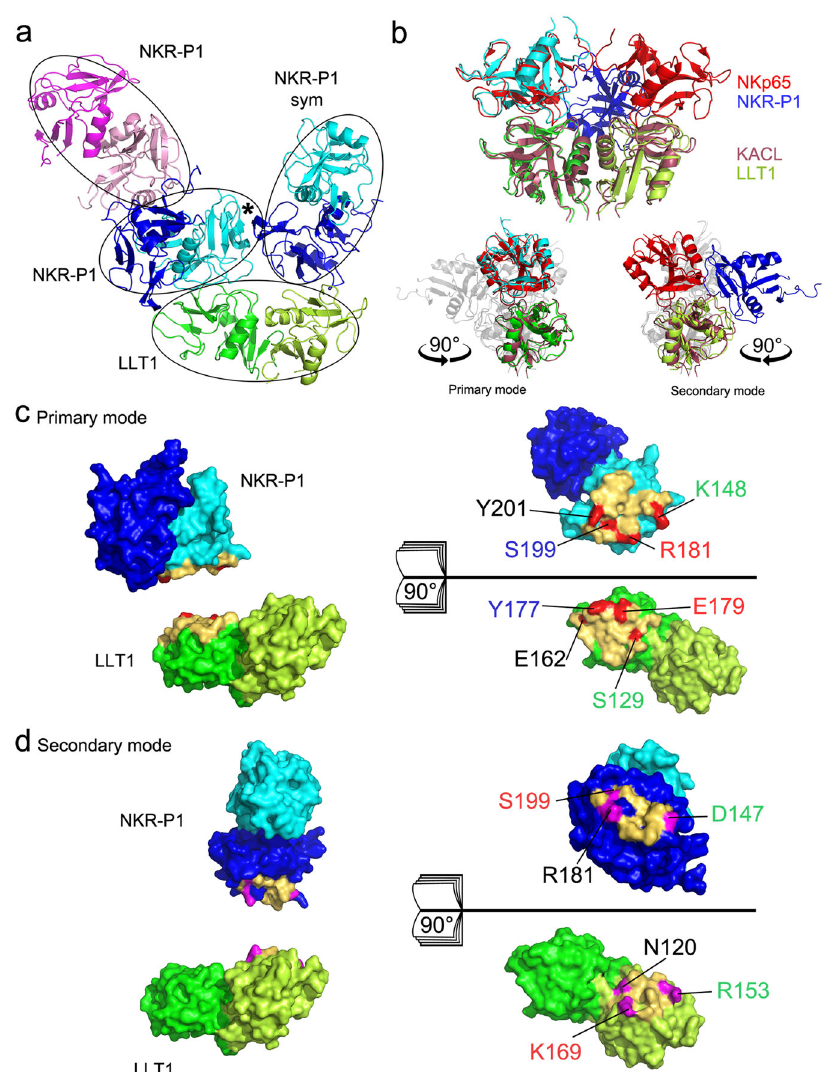
Fig. 4 | The structure of the NKR-P1:LLT1 complex shows two distinct binding modes.a Theoverallorganizationofthecomplexcrystalstructure.TheLLT1dimer (green/lemon)contactstheNKR-P1dimer,formedbytheblueandcyanmonomers. The second blue-cyan NKR-P1 dimer is related to the fi rst by crystal symmetry. The cyan NKR-P1 monomer interacts with LLT1 in the primary interaction mode, whereas the blue NKR-P1 monomer engages LLT1 using the secondary interaction interface. A black asterisk marks the mutual accessory contact of NKR-P1 bound in primary and secondary mode. Additionally, the asymmetric unit of the crystal containsanotherNKR-P1dimer(pink/magenta)lackingcontactwithLLT1. b Overall